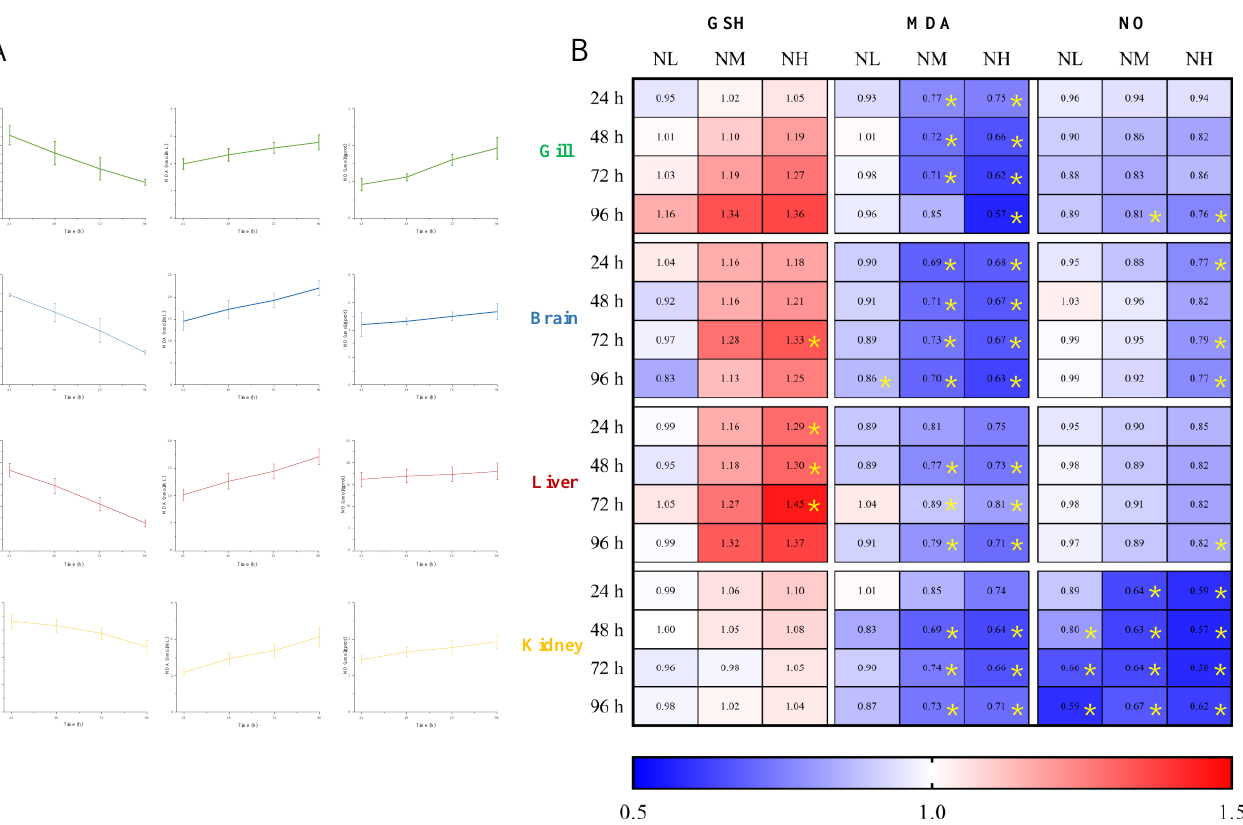
Figure 8. Effects of NCG on biochemical indexes of juvenile M. salmoides under ammonia stress. ( A ) The changes of biochemical parameters (GSH, MDA, and NO) in the gill, brain, liver, and kidney of M. salmoides under ammonia stress. The bars represent the mean ± S.D. ( n = 3). ( B ) The heat map of the fold change of biochemical parameters between the NCG added groups and the CK group * indicate statistical difference ( p < 0.05).